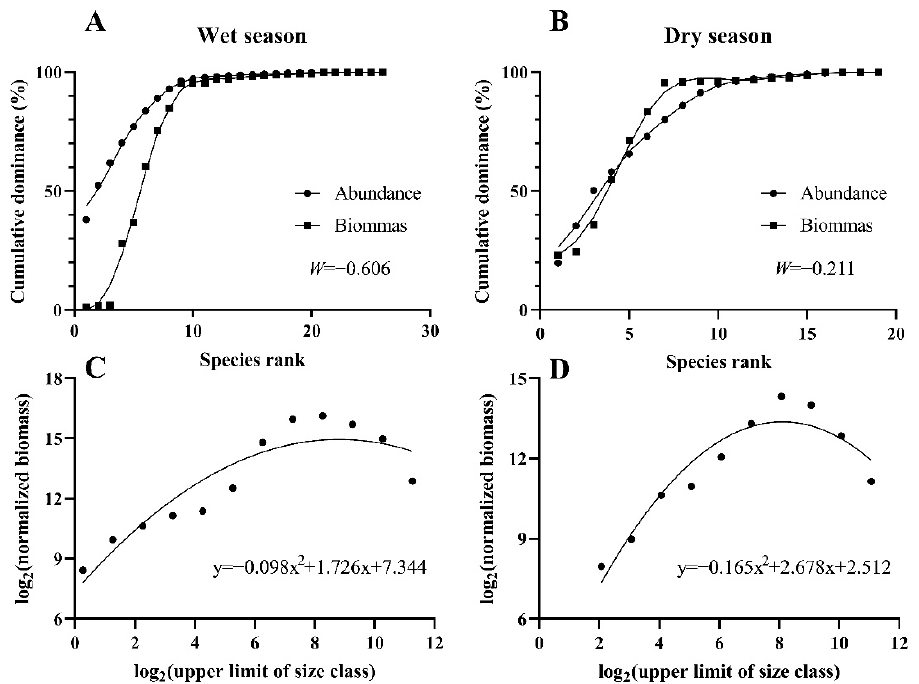
Figure 6. Abundance biomass comparison curves ( A , B ) and biomass spectrum ( C , D ) of the fish